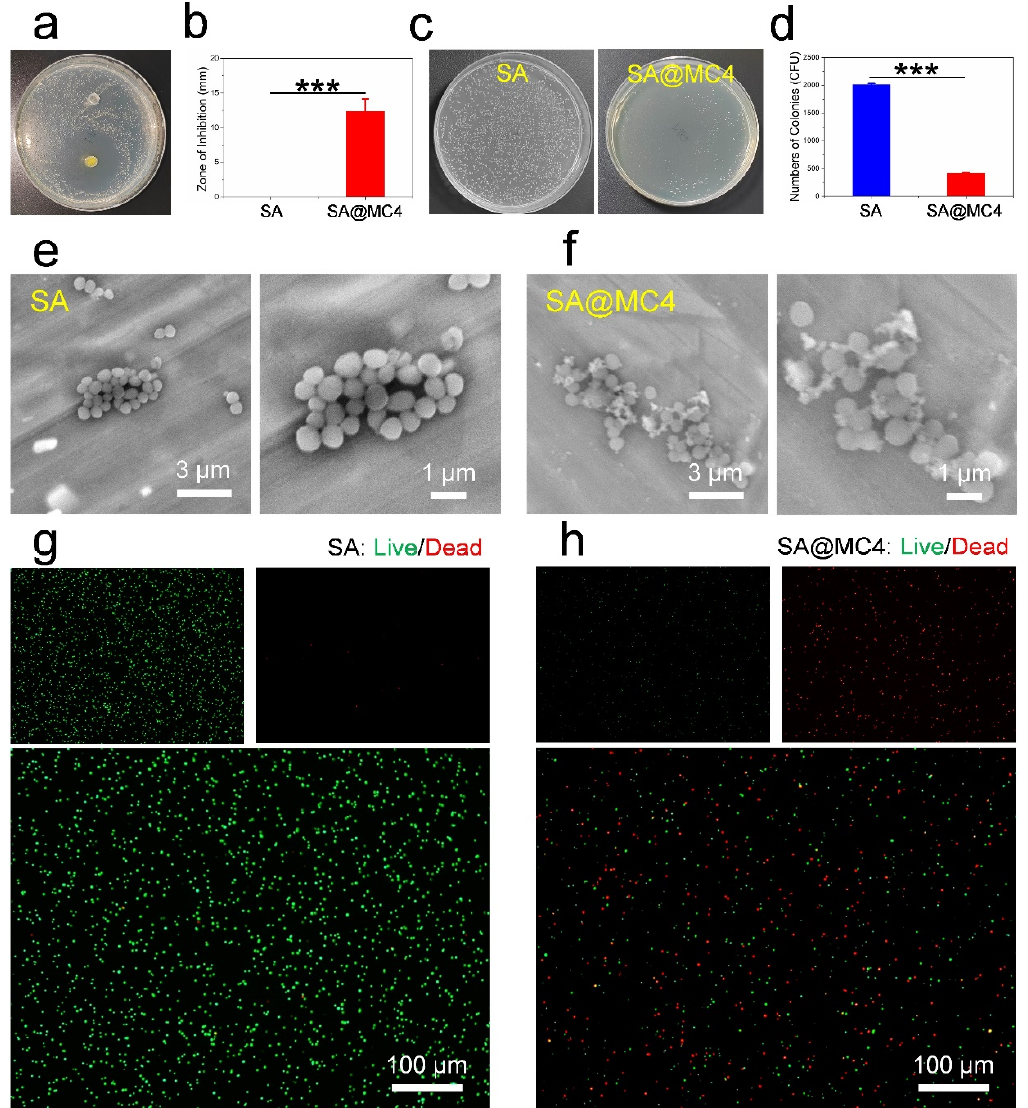
Figure 5. The antibacterial activity assessment of SA@MC injectable hydrogels. ( a , b ) Inhibition ring; ( c , d ) colony counting; ( e , f ) SEM images and ( g , h ) live/dead staining of bacteria after being cocultured with SA and SA@MC4 injectable hydrogels. *** p < 0.001 vs. the control group.